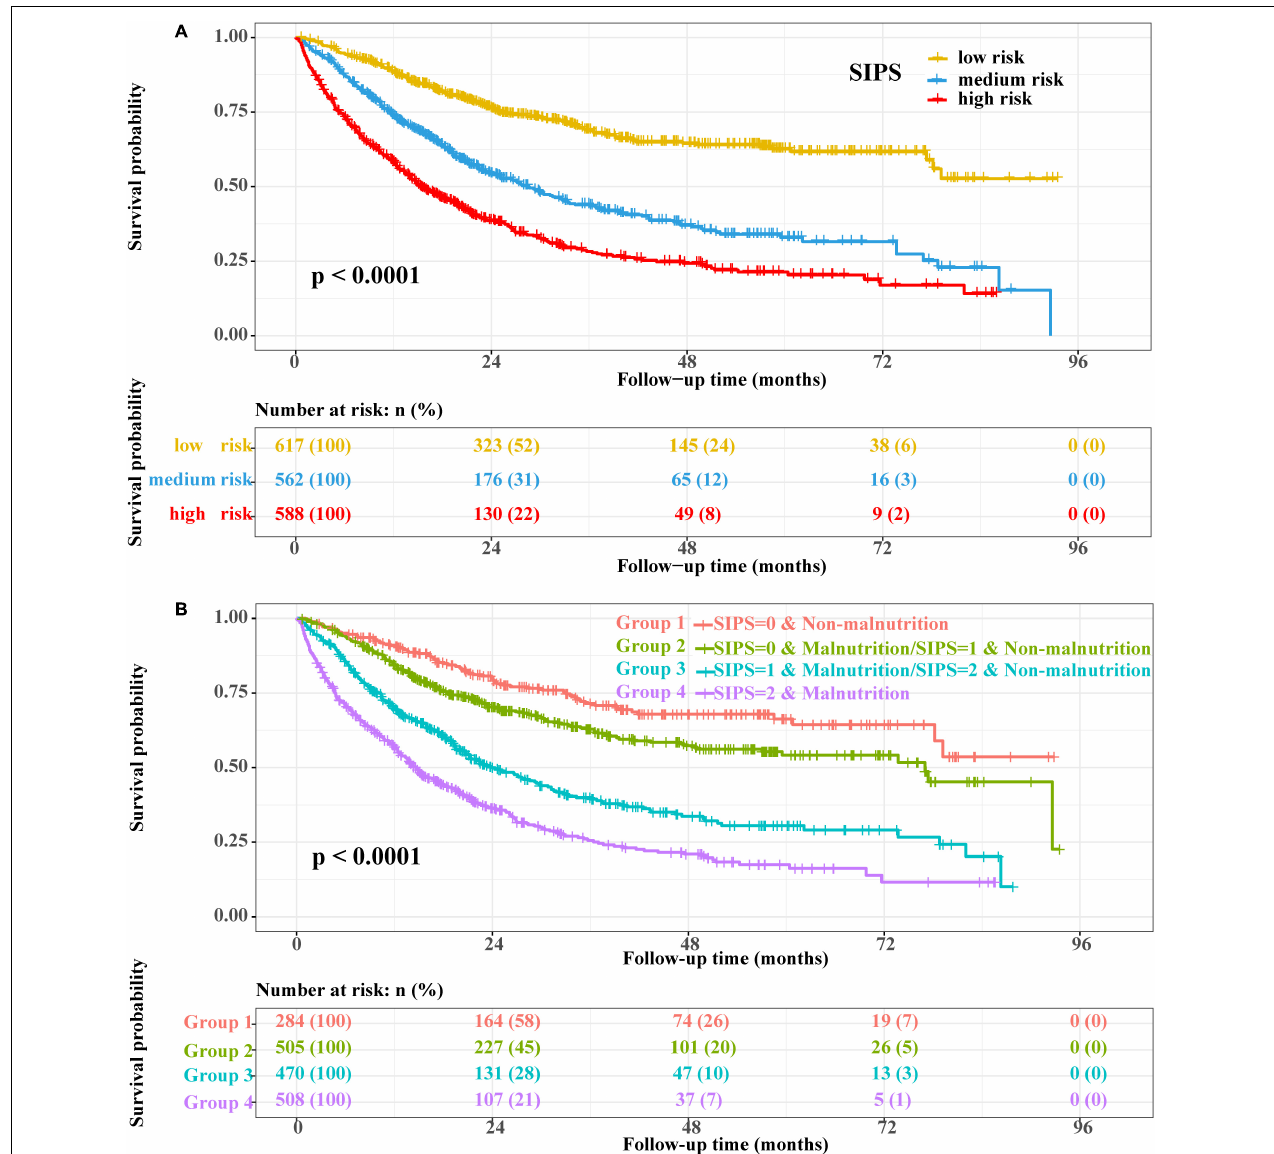
FIGURE 3 | The Kaplan–Meier survival curves. (A) SIPS and (B) SIPS combined with PG-SGA. SIPS: systemic inflammation prognostic score; PG-SGA: patient-generated subjective global assessment.